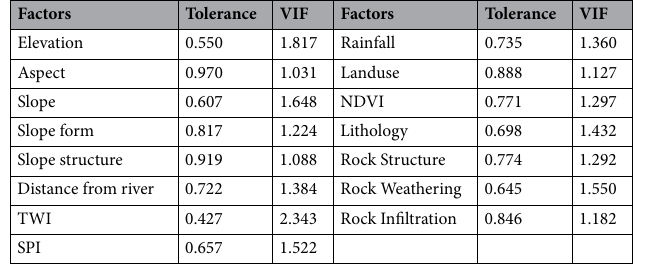
Table 5. Multicollinearity of Factors.